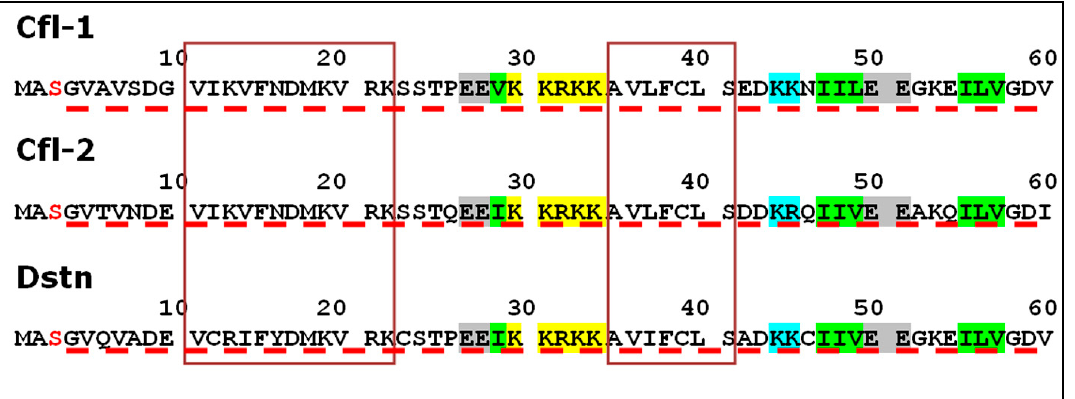
Figure 2. N-termini of human traditional cofilins Cfl-1, Cfl-2 and destrin (Dstn) according to UniProt (P23528, Q9Y281, P60981, respectively). Red “S” indicate serine residues which can be phosphorylated. Identical regions of amino acid sequences are framed. Nuclear localization signals are labeled in yellow. Repeating hydrophobic amino acid residues are labeled in green. Repeating positively charged amino acid residues are labeled in blue. Repeating negatively charged amino acid residues are labeled in gray. Starting parts of ADF-H domains (see below) are shown by the dotted red lines.